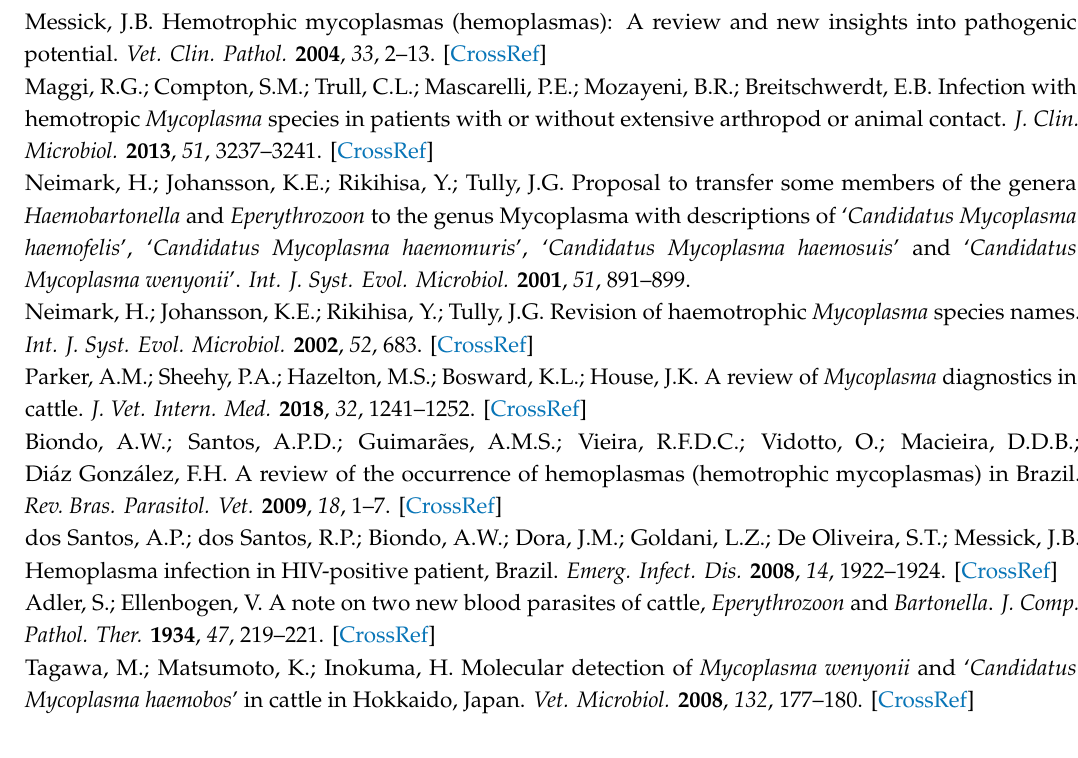
Table S1: Additional information concerning sex, age, breed, body condition score, and herd size was